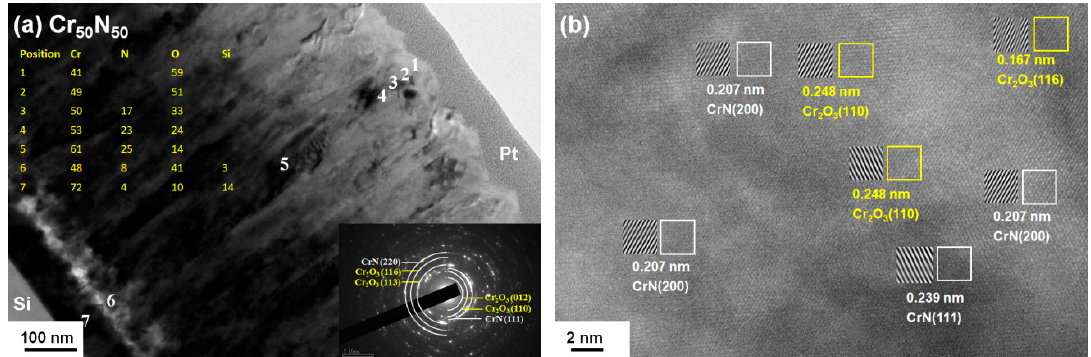
Figure 9. ( a ) Cross-sectional TEM image, selected-area diffraction pattern, and energy dispersive spectroscopy (EDS) results of the Cr 50 N 50 coating after annealing in 15 ppm O 2 –N 2 at 600 °C for 16 h; ( b ) the high-resolution TEM image at a depth of 150 nm.